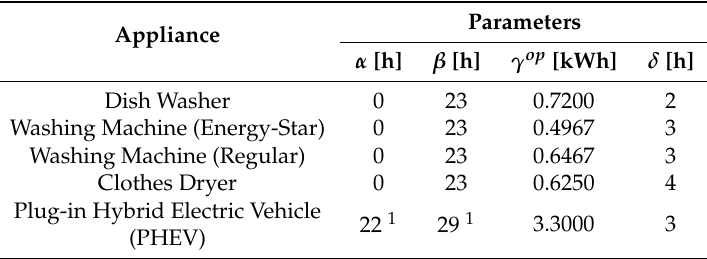
Table 1. Appliance energy consumption requirements (adapted from Reference [2]). Parameters Appliance α [h] β [h] γ op